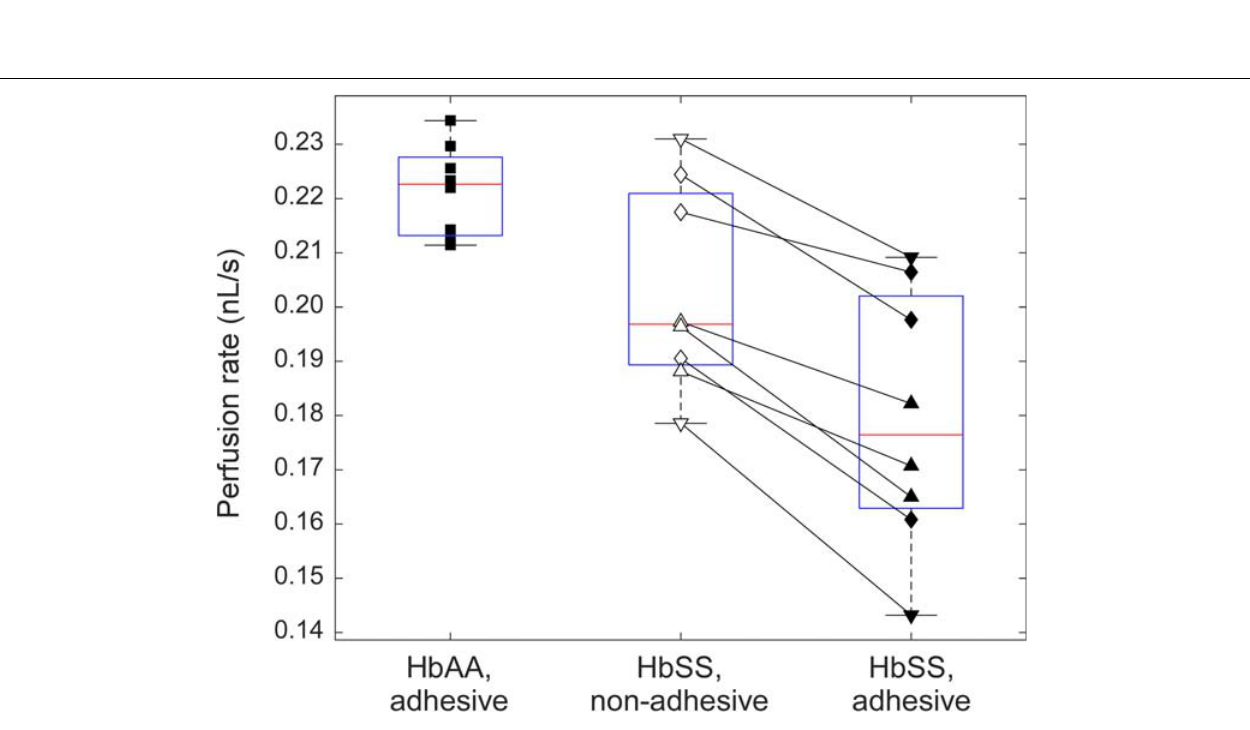
Frontiers in Physiology |